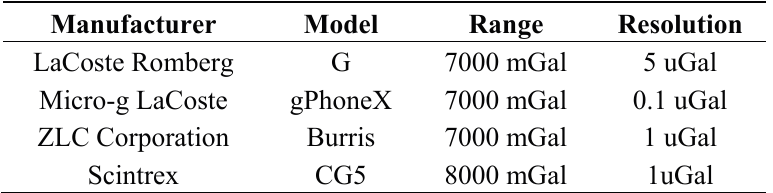
Table 1. Gravimeters used in volcanic monitoring.